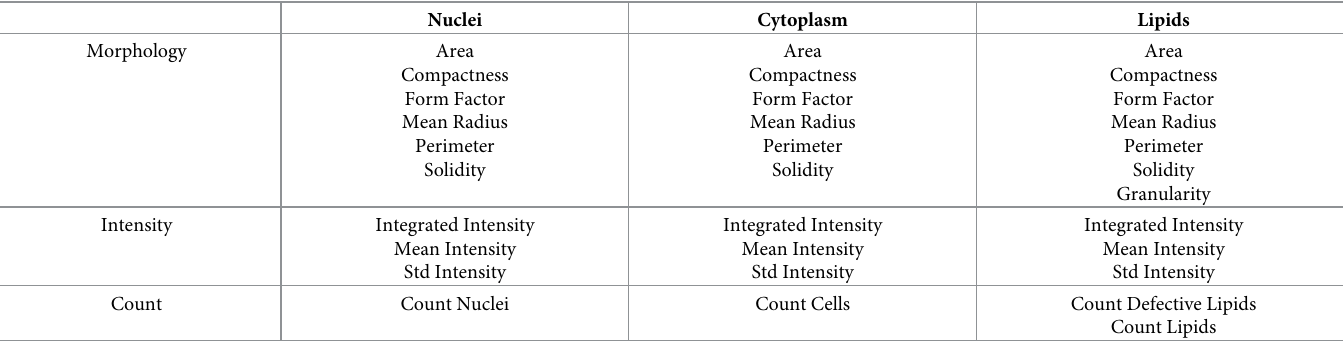
Table 1. Extracted features from